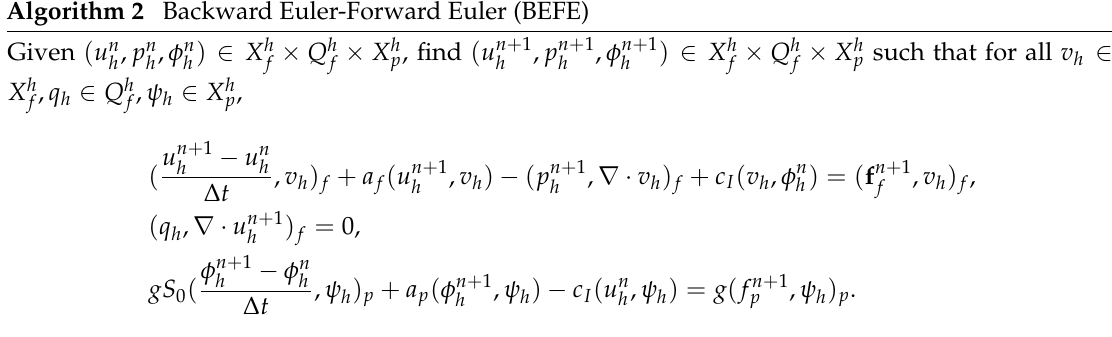
Algorithm 2 Backward Euler-Forward Euler